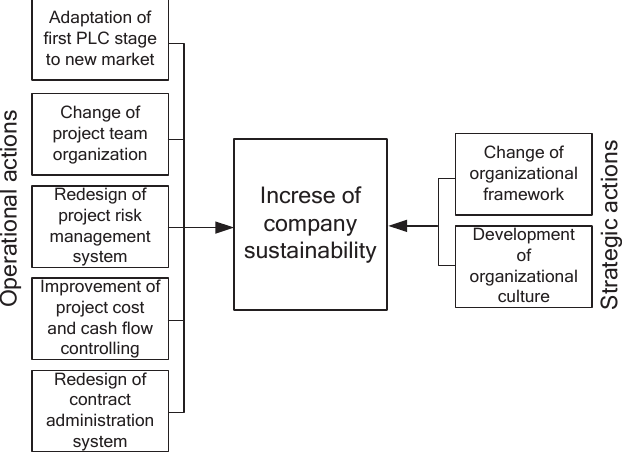
Fig. 4. Examples of organisational innovations under crisis conditions (devel- oped by the